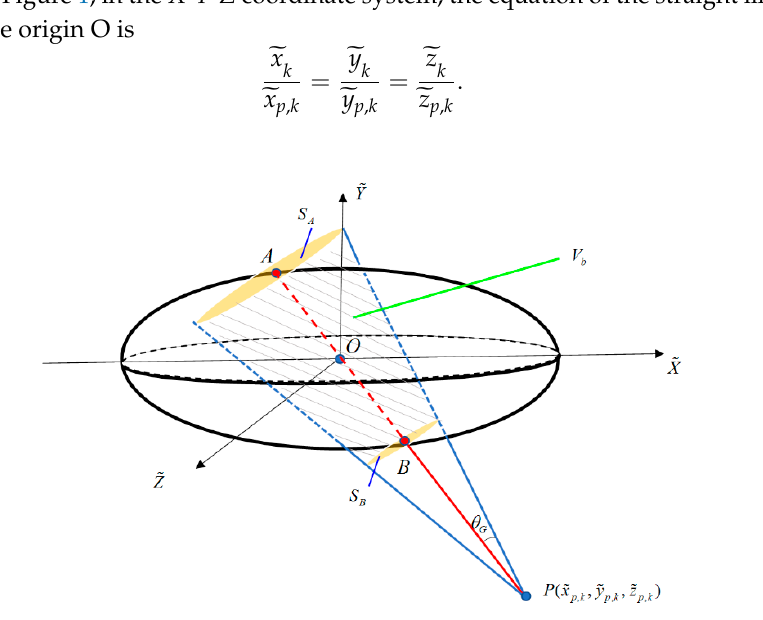
Figure 1. The schematic diagram of the MDC gate volume.